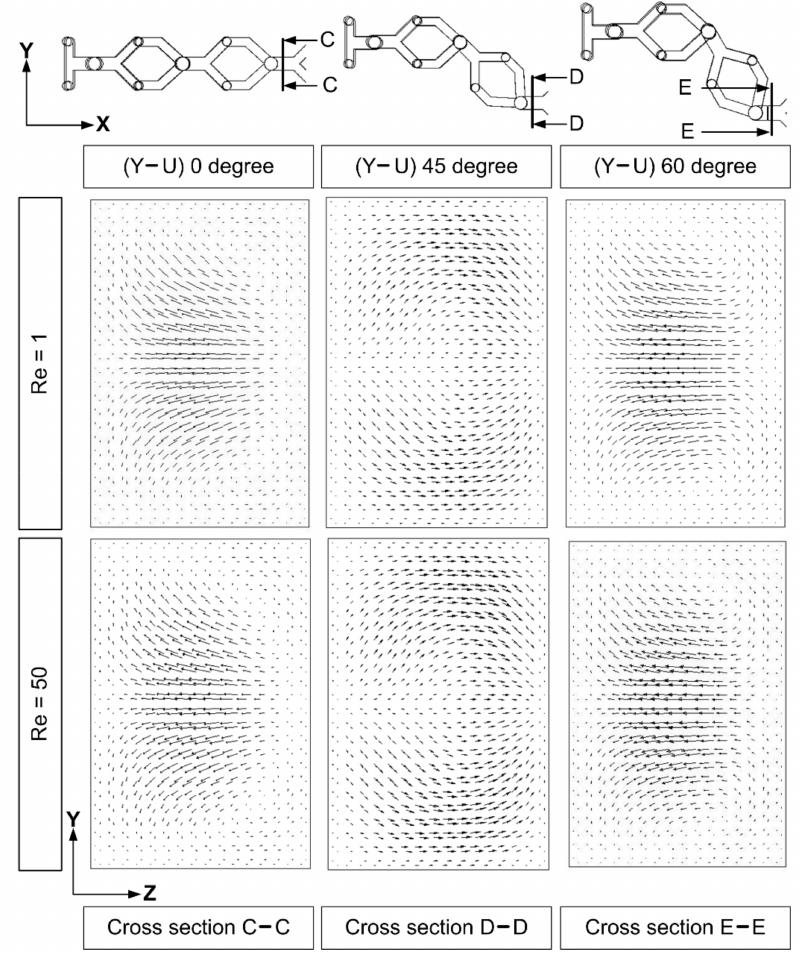
Figure 9. Velocity vector on the YZ-plane after second elements for different ( Y − U ) Re = 1 and Re =